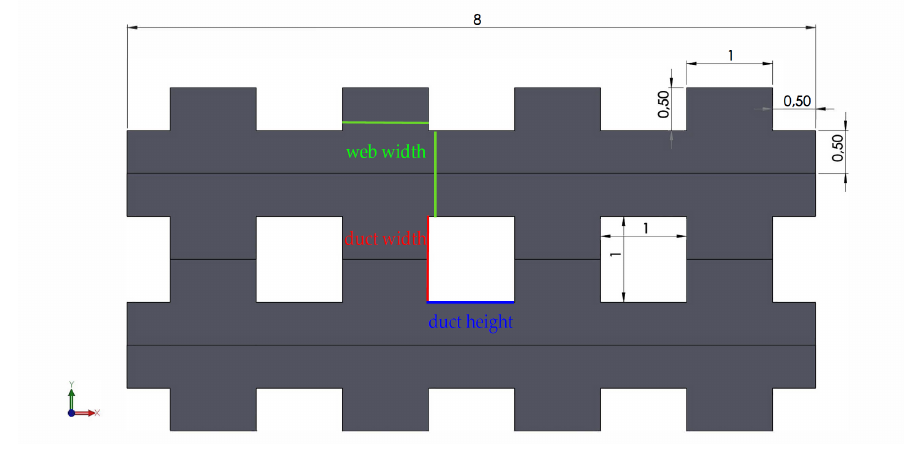
Figure 8. Cross-section of the stacked profiled